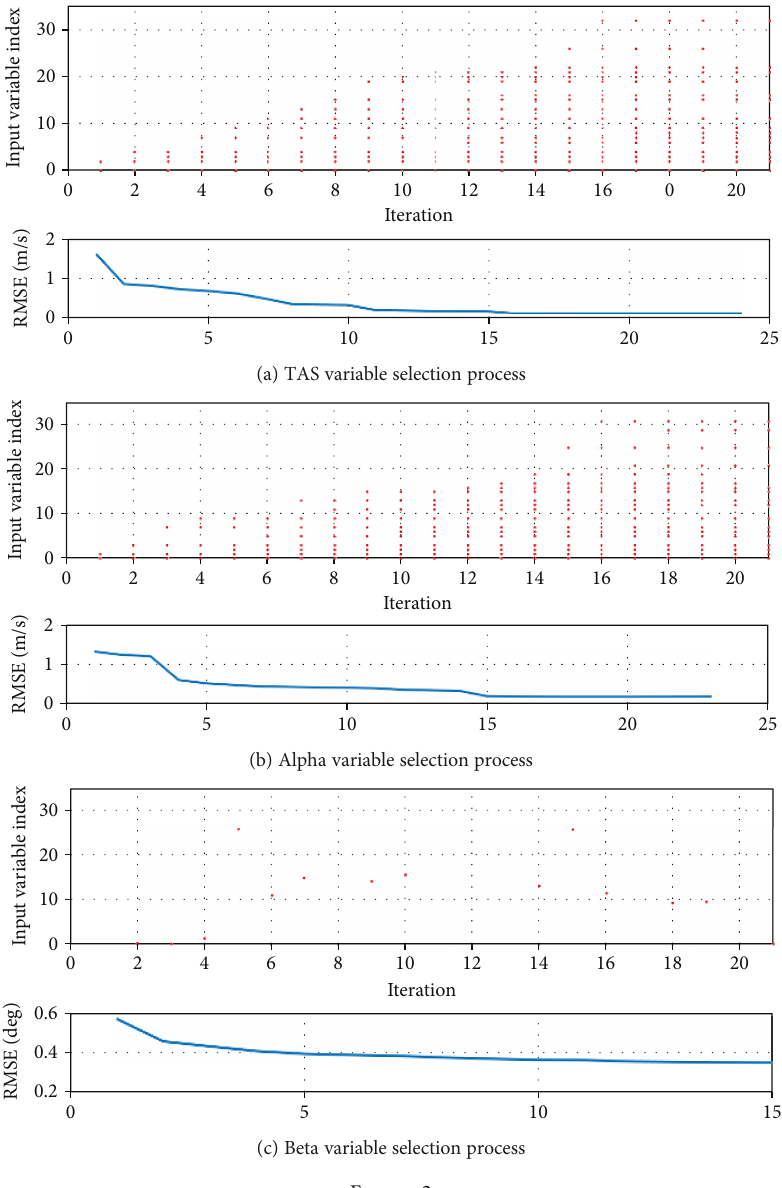
(b) Alpha variable selection